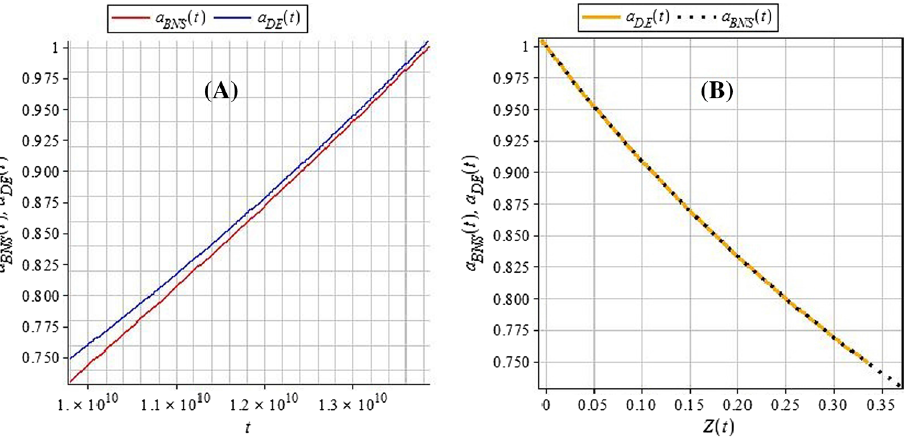
Fig. 5 Plot a indicates the scale factors a D . E . ( t ) and a B . N . S . ( t ) versus time t at the time range [9.8Gyr, 13.8Gyr], while b shows both scale factors versus their own redshifts z (i.e. z D . E . and z B . N . S . ) at the same time range